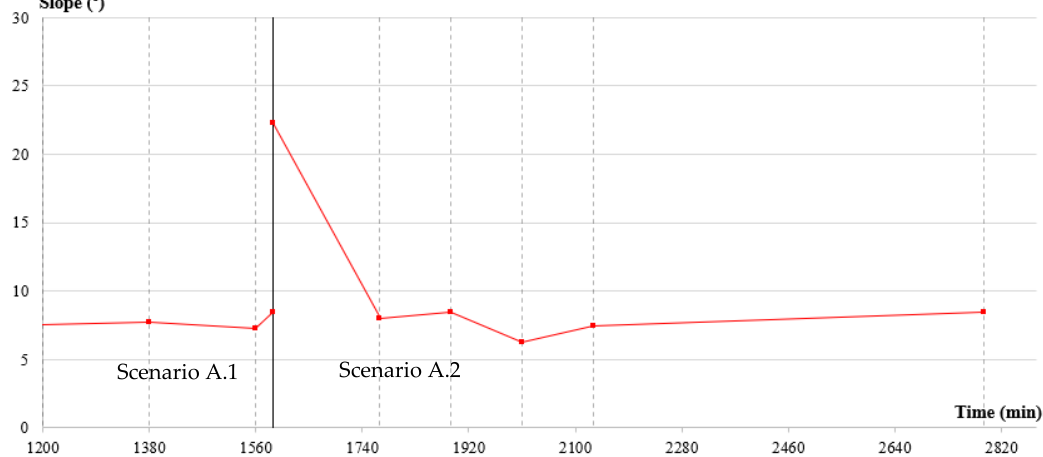
Figure 11. Timeline for mean beach shoreface slope. The vertical black line represents the transition between scenarios A.1 and A.2. The vertical black dashed lines represent the instants when the equipment was